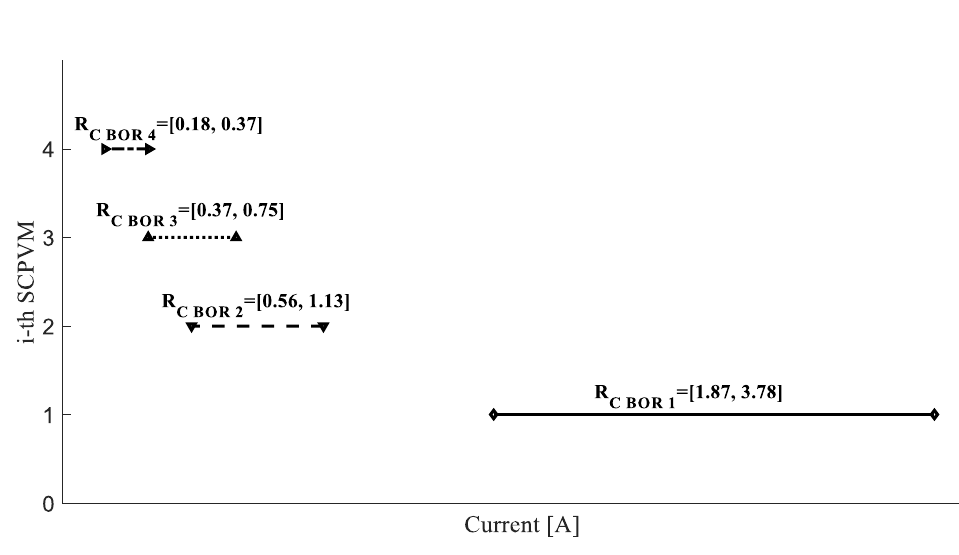
Figure 14. Optimal current intervals (Case I).